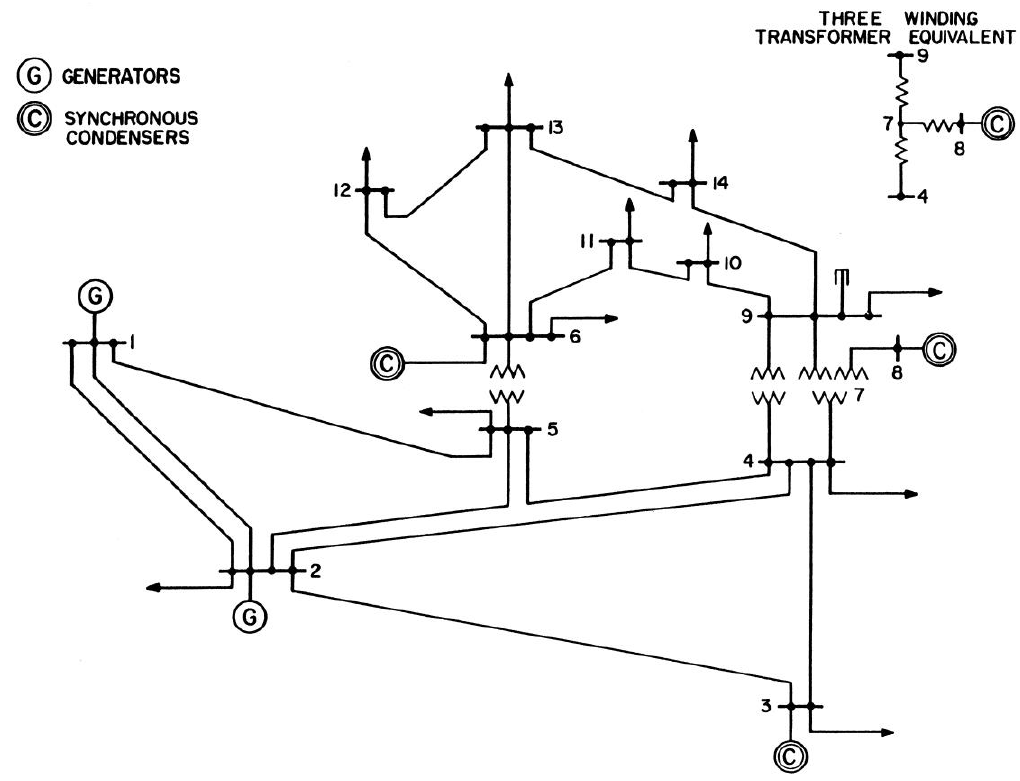
Figure 1. The IEEE 14-node test system.